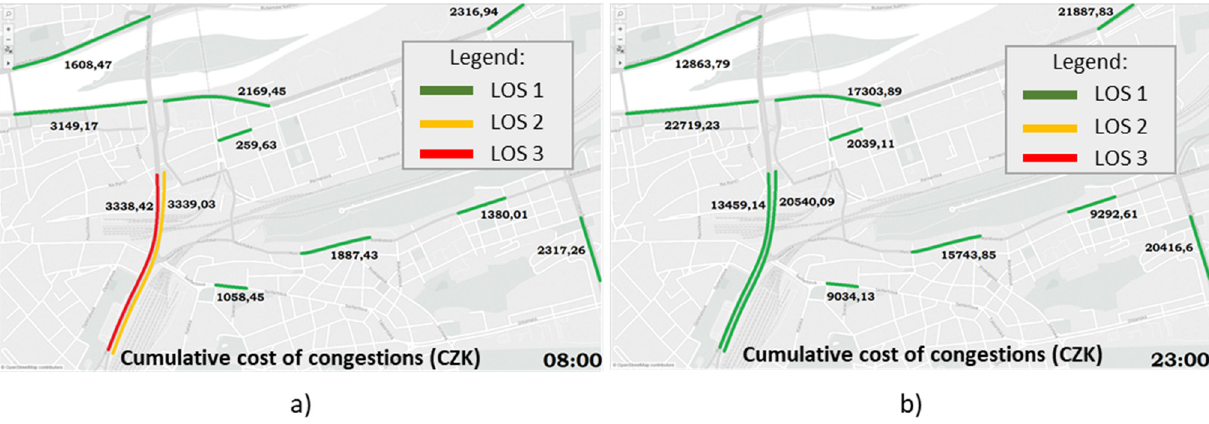
Figure 5. The cumulative cost of congestions (in CZK) and the level of service (LOS 1—green; LOS 2—yellow; LOS 3—red) as computed for an example network in Prague at ( a ) 8 a.m. and ( b ) 11 p.m.